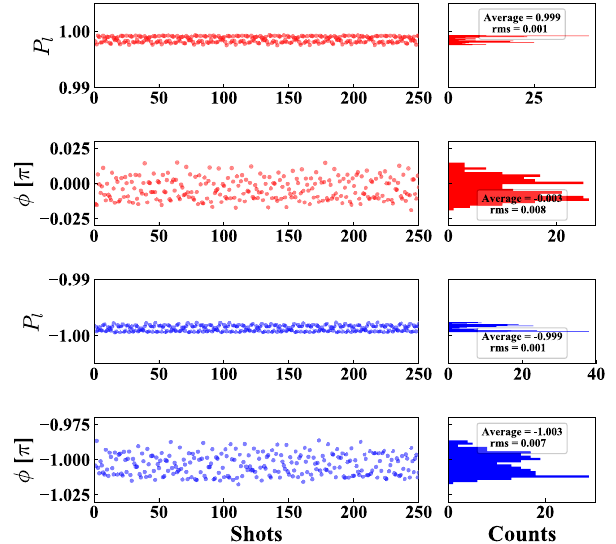
FIG. 6. P l and phase difference ϕ are shown when the phase shifter is tuned to 45° linear and 135° linear polarization. The histograms show the distribution of the data. The average polari- zation degree j P l j approach 99.9% with 0.1% RMS linearly (red) and 135° linearly (blue) polarized state. The averaged value for each quantity is obtained over 250 shots.